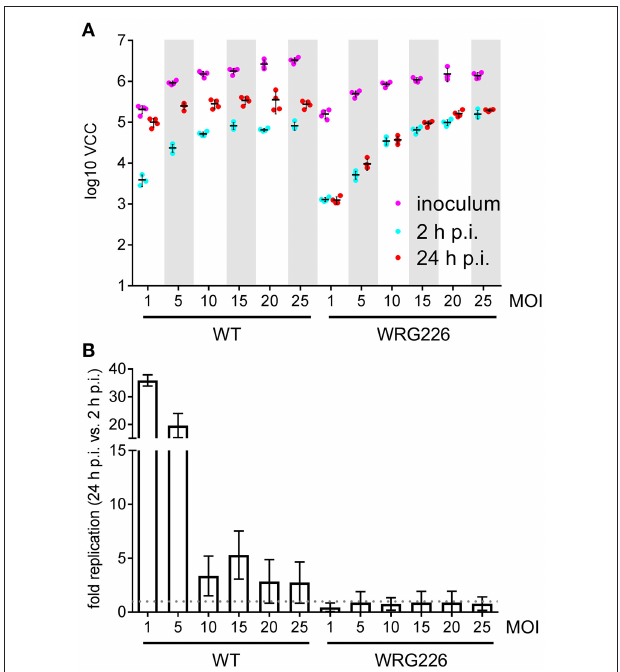
FIGURE 4 | Replication of Salmonella within RAW264.7 macrophages. (A) Two 96-well plates with RAW 264.7 macrophages were infected in parallel with the strains and MOIs as indicated. In the first plate, bacteria in the inoculum (magenta) and intracellular bacteria after 2h post-infection (p.i.) (cyan) were determined by VCC. The second plate was used for enumeration of intracellular bacteria after 24h of infection (red). Means and standard deviations from one representative out of three similar experiments done in 4-fold replicates (dots) are depicted. (B) From the data of three independent biological replicates the fold replication of the strains were calculated. The maximum capacity of intracellular WT bacteria to replicate is reached after 24h with an MOI of 1. The T3SS-2 deficient strain WRG226 showed no net replication (dashed gray